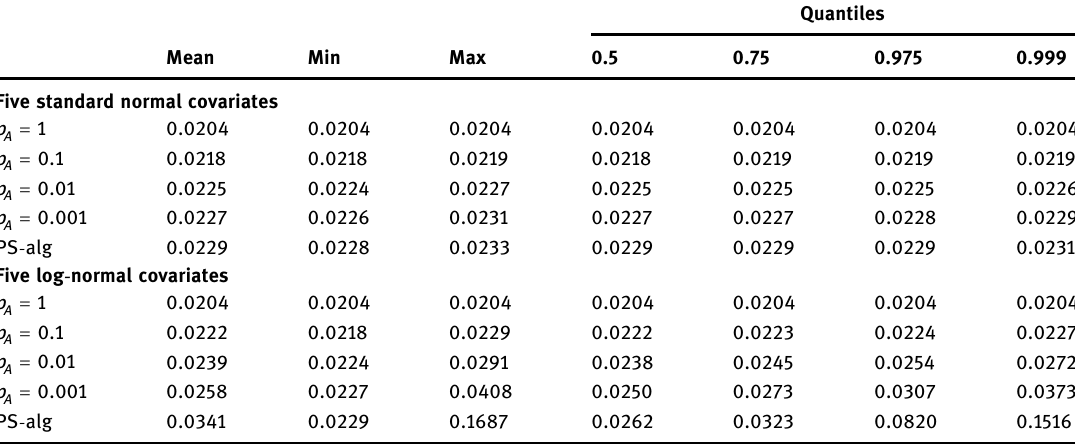
Table 1: Distribution of assignment correlation for di ff erent designs